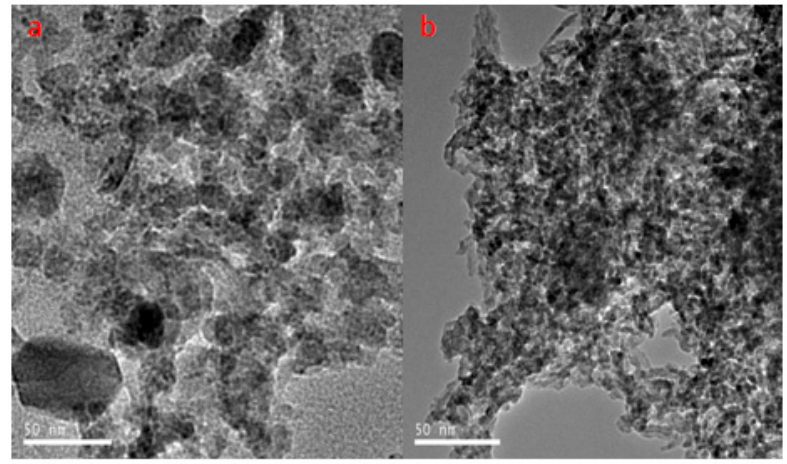
Figure 7. TEM photos of the products with different precursor concentration ( a ) 0.005 mol; ( b ) 0.04 mol.